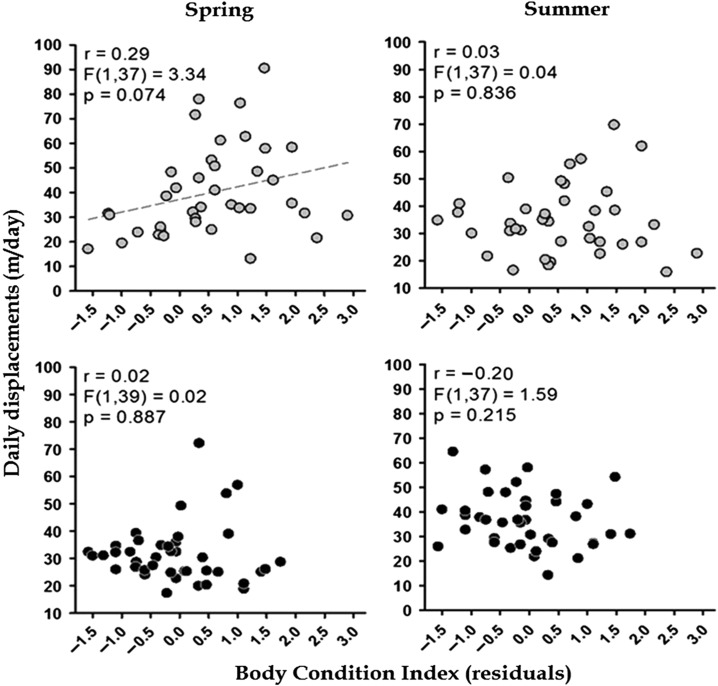
Relationship between body condition index and mean (±SEM) daily displacements of radio-tracked females (grey symbols; top panels) and males (black symbols; bottom panels). Individuals were monitored in spring (left panels) and in summer (right panels). Body condition index was calculated at the beginning of each season. The dashed line indicates a correlation close to statistical significance.